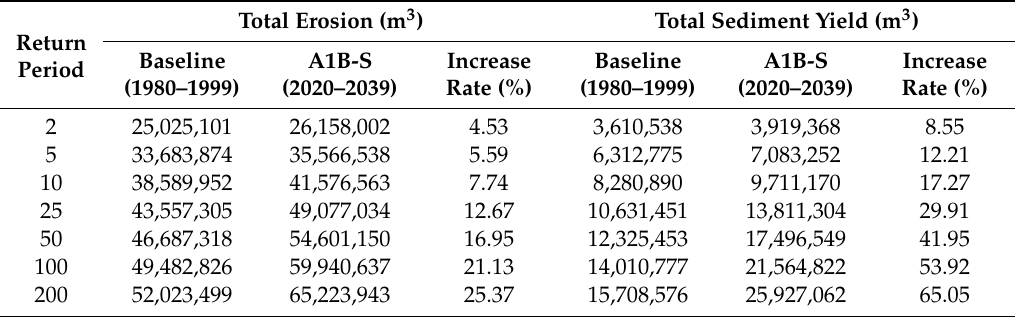
Table 2. Soil erosion and sediment yield increase rates under baseline and A1B-S scenarios for various return periods.